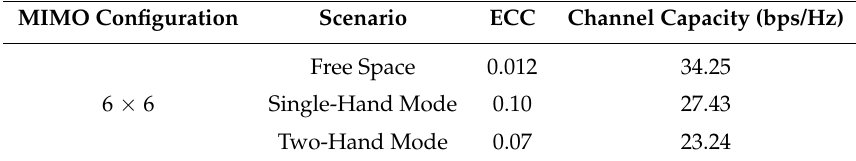
Table 2. MIMO channel capacities and ECC for free space (without hand) and customer’s hand scenarios based on simulated results.